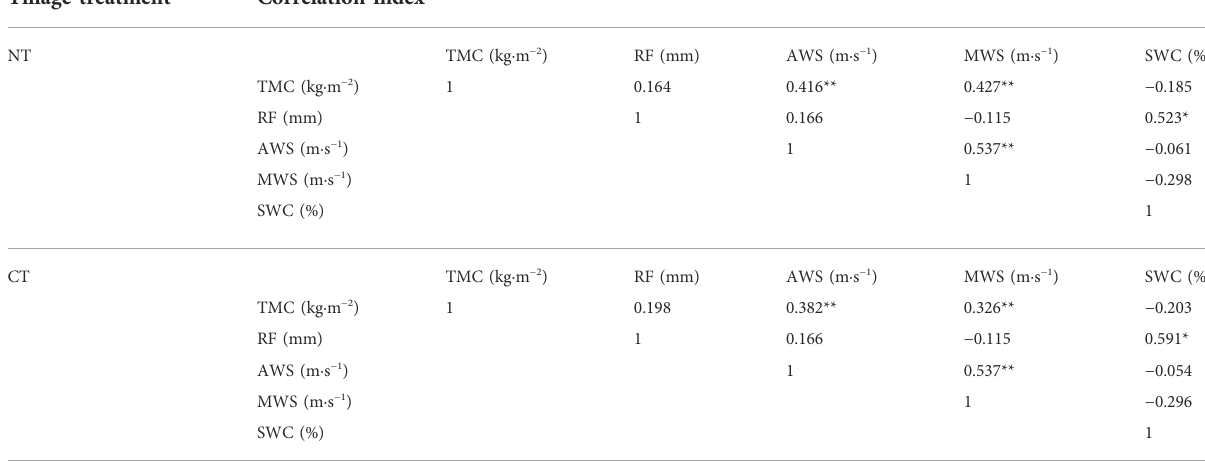
TABLE 3 Correlation between the total erodible particles collected by the sampler (TMC, kg · m − 2 ), rainfall (RF, mm), average wind speed (AWS, m · s − 1 ), maximum wind speed (MWS, m · s − 1 ), and soil water content (SWC, %) in NT and CT. Tillage